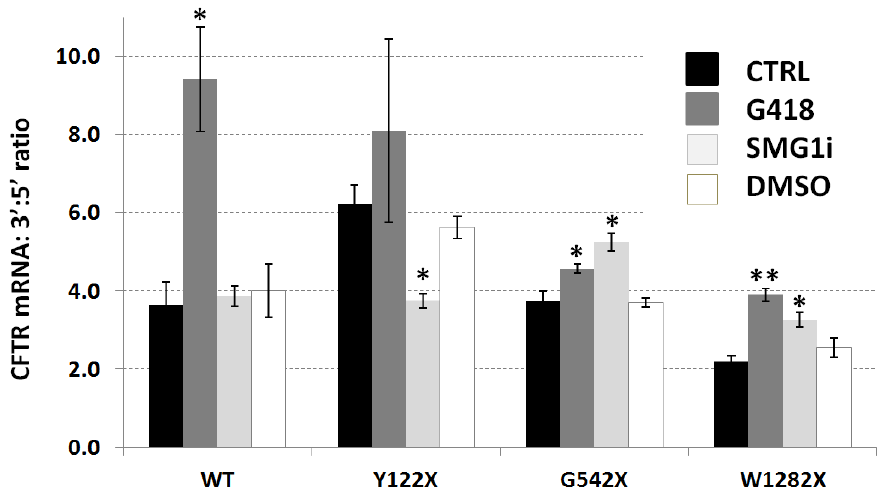
Figure 4. Ratios of abundance of 3 ′ and 5 ′ CFTR mRNA, measured by RT-qPCR. Ratios of 3 ′ to 5 ′ transcript abundance were determined for 16HBE cells expressing wt-CFTR and three different PTC mutations (Y122X, G542X, W1282X: x-axis) under four conditions, shown in four shades (CTRL: untreated cells; G418: 500 µg/mL, 24 h; SMG1i: 1 µM, 24 h; DMSO: 0.5%, 24 h). Values shown are means ( n = 3) ± SEM, and significant differences from untreated cells are indicated by asterisks (* p < 0.05; ** p < 0.01).